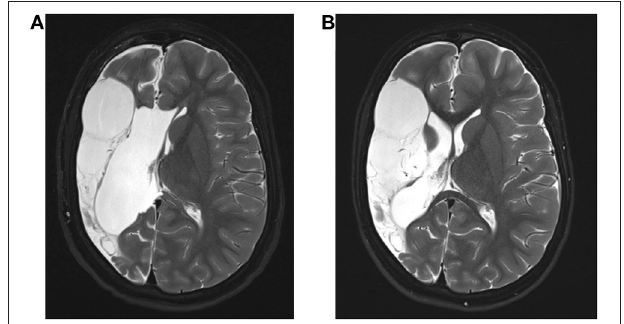
FIGURE 1 | Magnetic resonance imaging (MRI) of the patient. (A) Shown is the preoperative MRI of the 2; 10 year old patient. (B) Normal MRI of the patient 6 months after surgery showing the malacic transformed medial infarct on the right side with no evidence of hemorrhage, infarction, or liquor circulatory